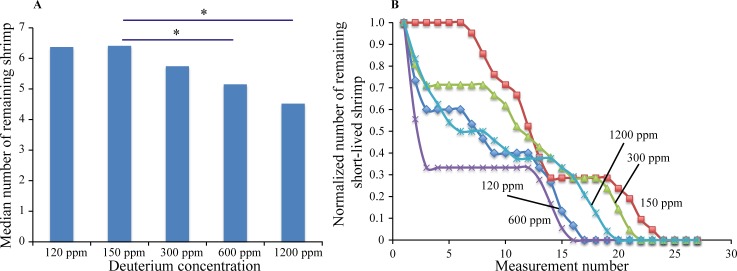
Shrimp survival in BYOES under the period of 20 months.(A) The median number of shrimp in BYOES over the observation period of 20 months as well as the Student’s t-test (two-tailed, unpaired) results for each deuterium content. 150 ppm corresponds to normal terrestrial deuterium content. (B) The survival plots after 3-point smoothing. The number of shrimp that were still alive after 20 months was subtracted for each D content and the obtained value renormalized to day 1.